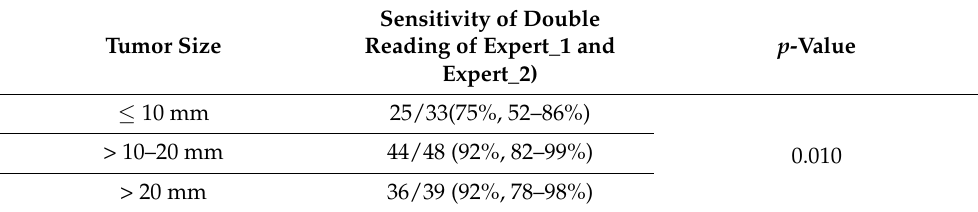
Table 4. Per-lesion diagnostic performance (in terms of sensitivity) of DWI of a double reading of expert according to different tumor size.